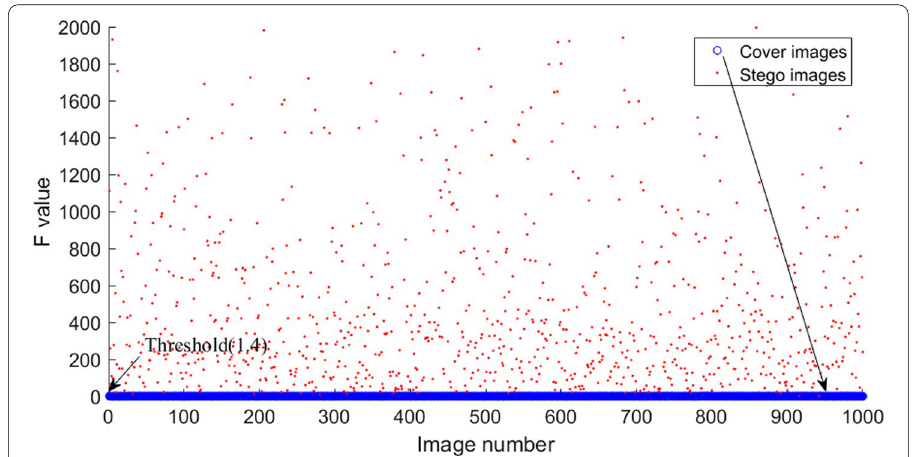
Fig. 8 Distribution of the cover and stego images at an embedding ratio of 100% (type 1 of the PVD interval)